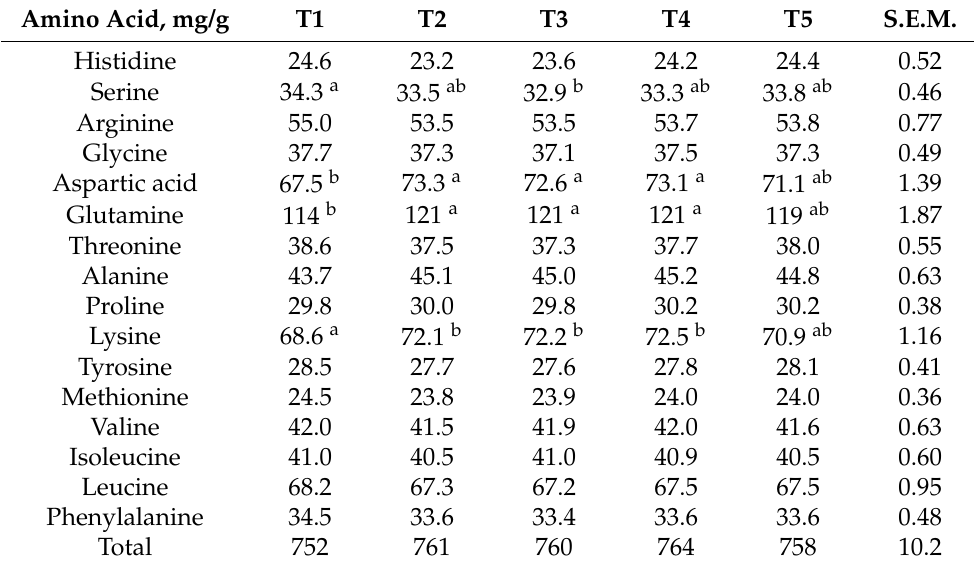
T1 = the control group, no inclusion of BSFL in the diet; T2 = the 2.5% BSFL starter period followed by 5% BSFL grower and finisher periods; T3 = the 5% BSFL starter period followed by 10% BSFL grower and finisher periods; T4 = the 7.5% BSFL starter period followed by 15% BSFL grower and finisher periods; T5 = the 10% BSFL started period followed by 20% BSFL grower and finisher periods; a,b within rows, means with a different superscript